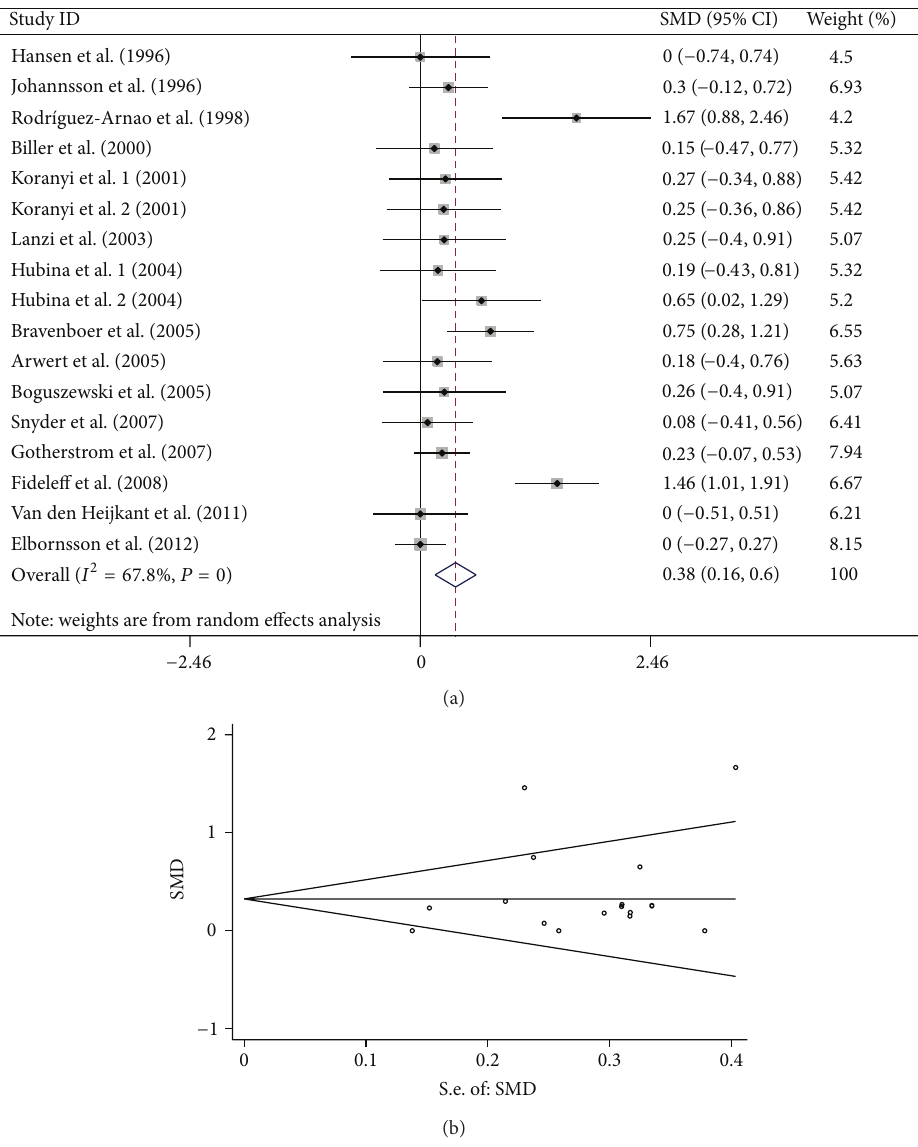
Figure 2: Forest plot and funnel plot for the association between GH treatment and BMD of FN. (a) Forest plot using a random effects model. (b) Funnel plot using Begg